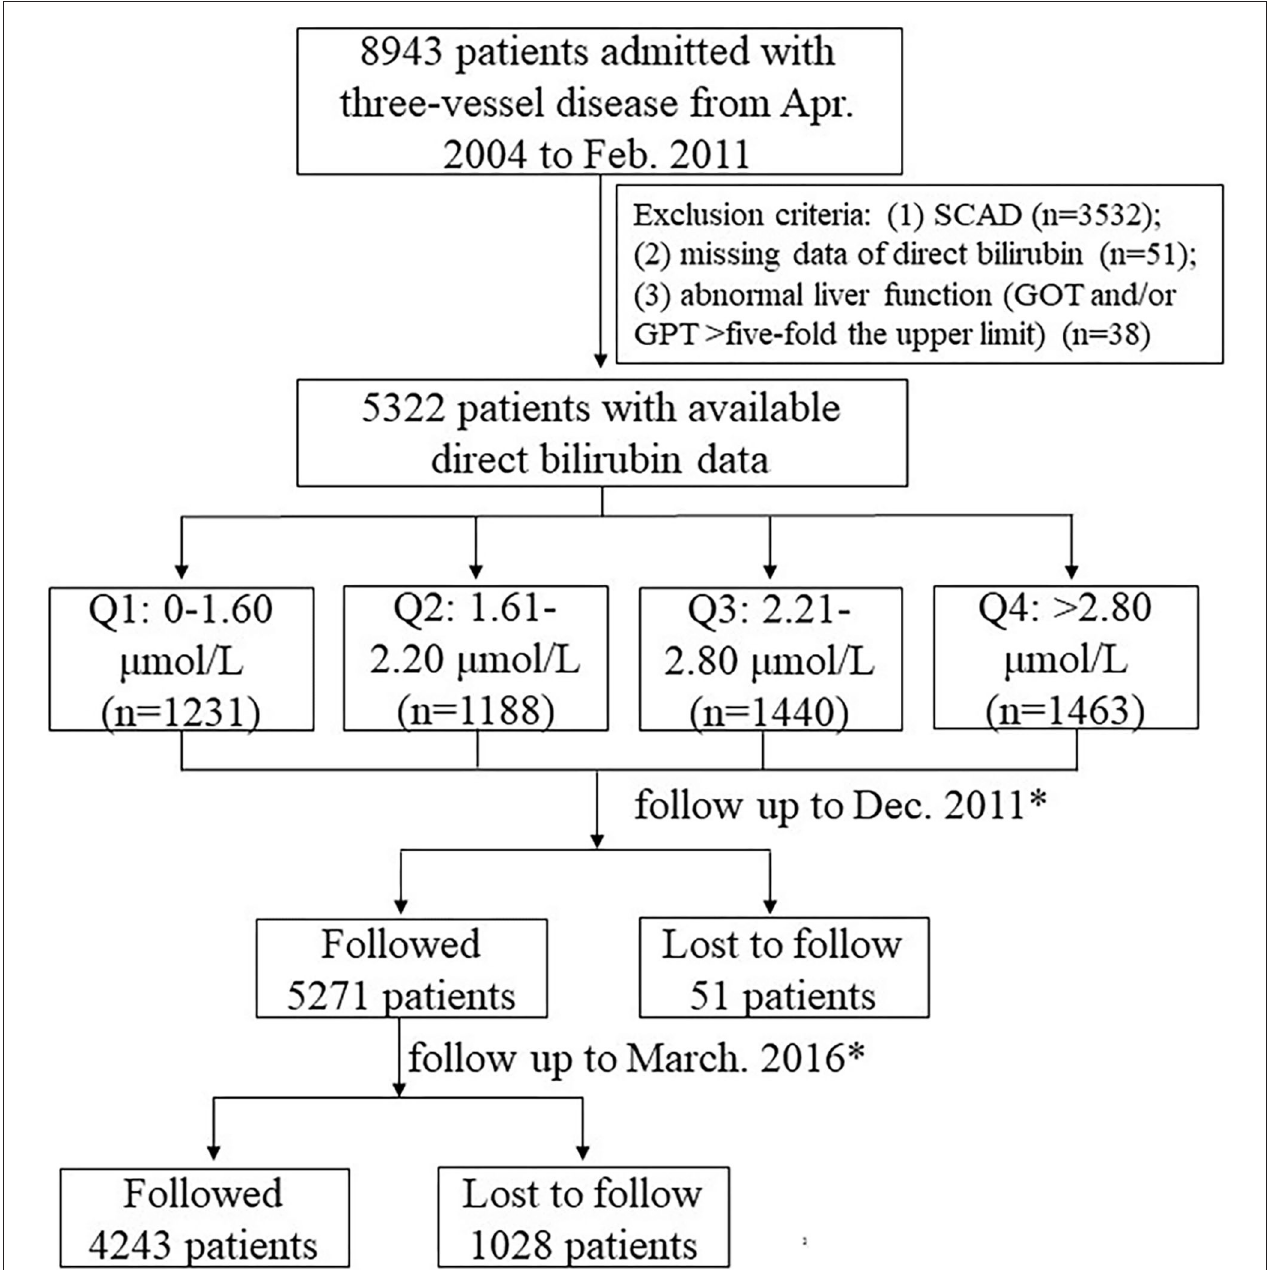
FIGURE 1 | Flowchart of patient